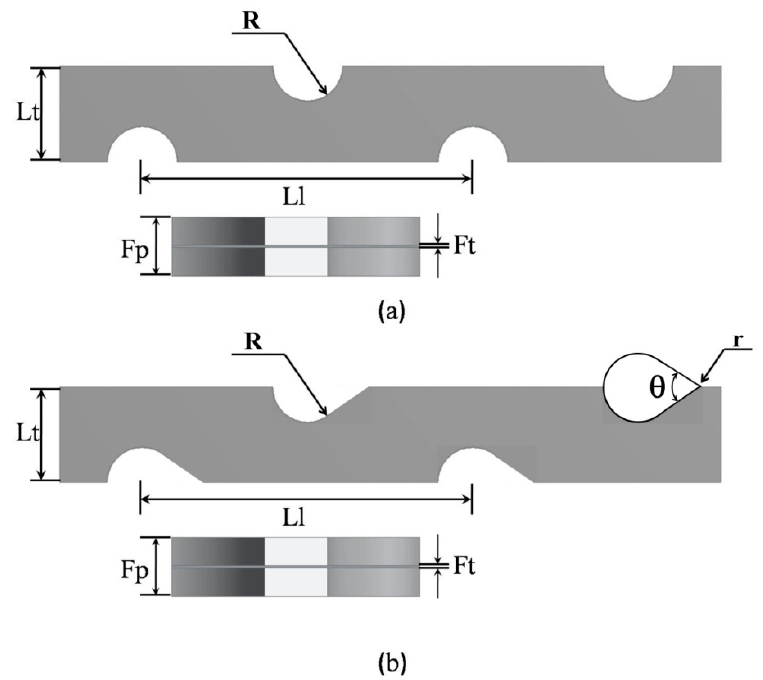
Figure 1. Definitions of geometrical parameters of the circular tube and streamline tube plate fin-tube heat exchanger: ( a ) circular tube plate fin-tube heat exchanger; ( b ) streamline tube plate fin-tube heat exchanger Table 1. The parameters of circular tube and streamline tube fin-tube heat exchanger.